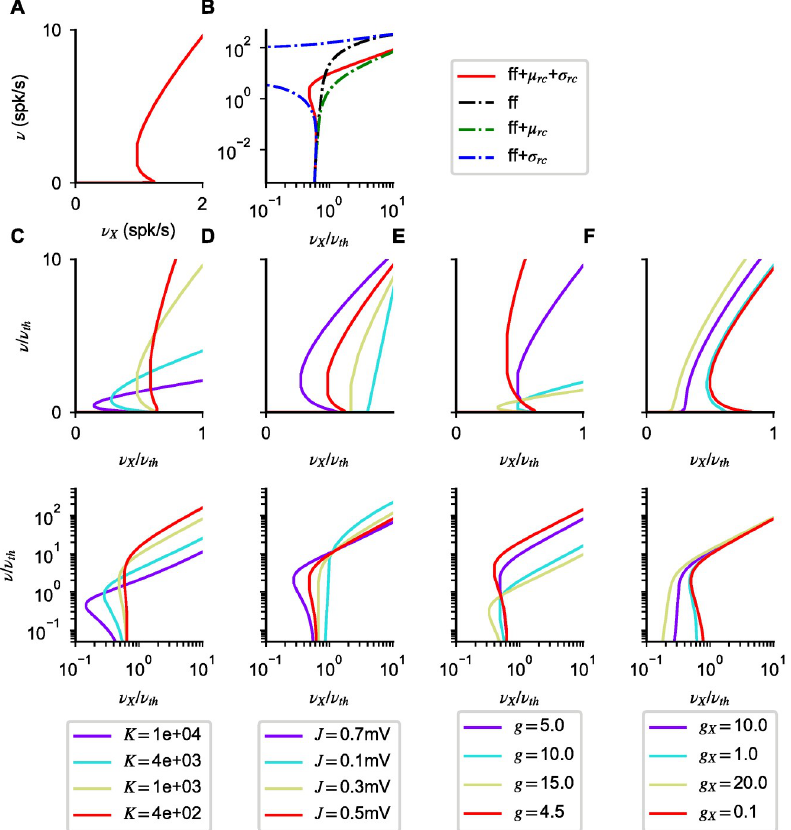
Fig 5. Response-onset nonlinearities in model A. ( A ) Network response computed from Eqs (3)–(5) (red). ( B ) As in panel A but in log-log scale to highlight the behavior at low rate. Response at low rates is determined only by feedforward inputs (black, Eq (30)); effects of recurrent noise (blue) and mean (green) become relevant at higher rates, with opposite effects on the number of solutions. ( C-F ) Effects of different parameters on the number of solutions in network response; responses are shown in linear (top) and log-log (bottom) scale. Simulation parameters, unless otherwise specified in legend, are K = 10 3 , J = 0.5 mV, g = 5.0, g = 1, τ = 20ms. X